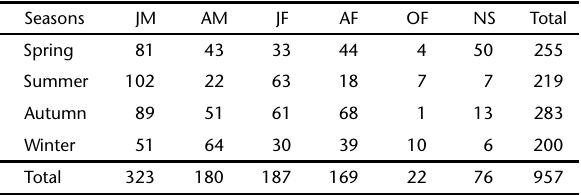
Table II. Number of individuals of Aegla platensis collected during the four seasons in the Lajeado Bonito stream, Uruguay Basin, Rio Grande do Sul state. (JM) Juvenile males, (AM) adult males, (JF) juvenile females, (AF) adult females, (OF) ovigerous females, (NS) non-sexed